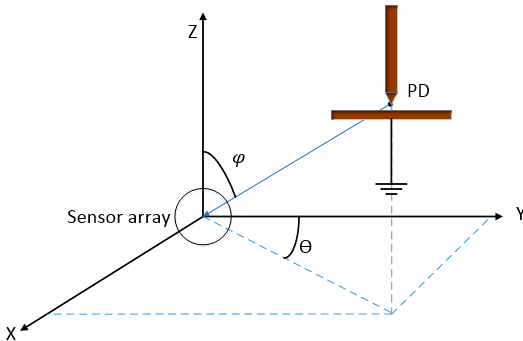
Figure 1. Coordinate system in space for the corona discharge direction.